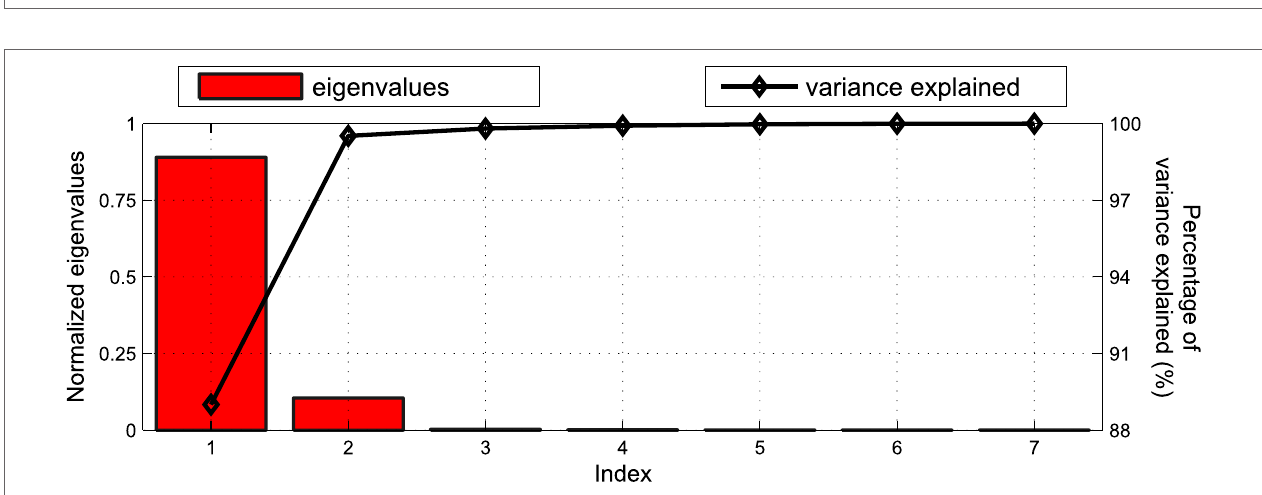
FIGURE 5 | Strain evolution of the second sensor of each chain during the structure’s operational state .